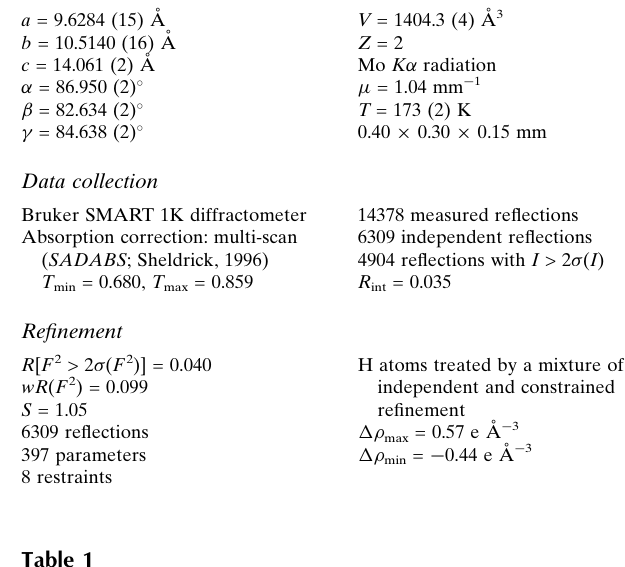
Hydrogen-bond geometry (A˚ , (cid:2) ). D —H (cid:1)(cid:1)(cid:1)